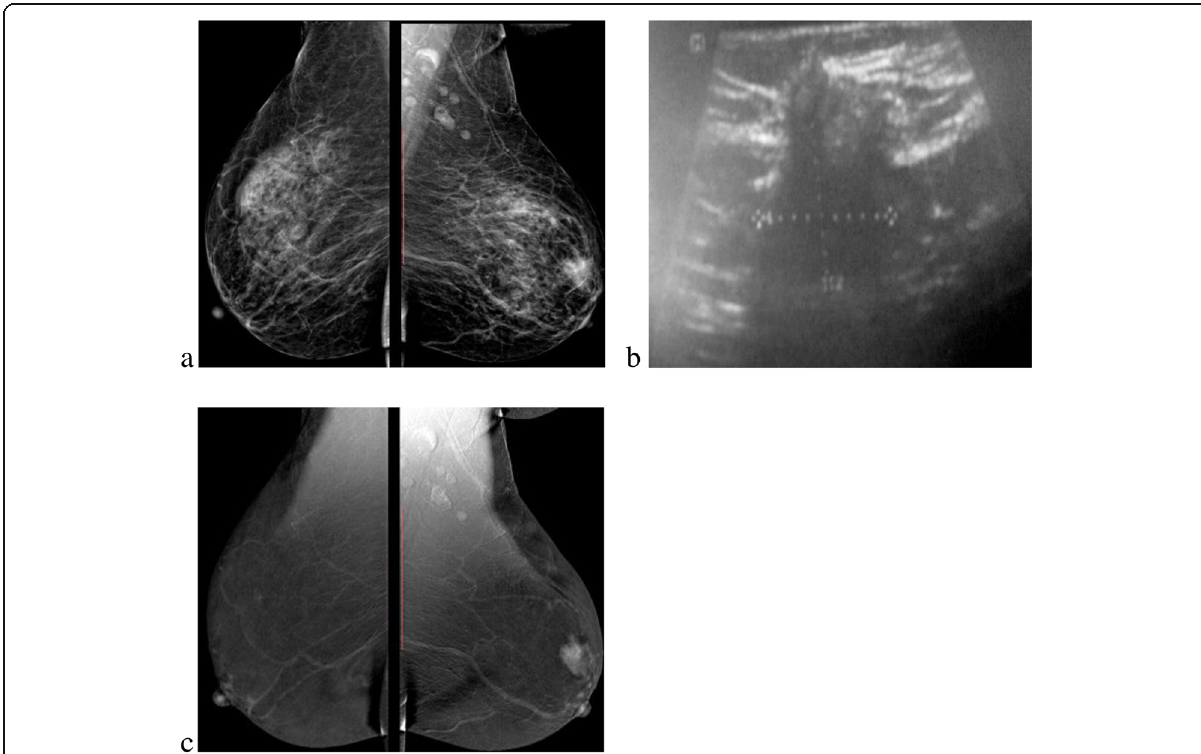
Fig. 1 A case of invasive ductal carcinoma grade II. Image ( a ) shows left focal asymmetry by low energy, ( b ) shows an irregular speculated margin hypoechoic lesion on ultrasound. c Recombined image of CEDM showing enhancing mass lesion of irregular shape, irregular margin,